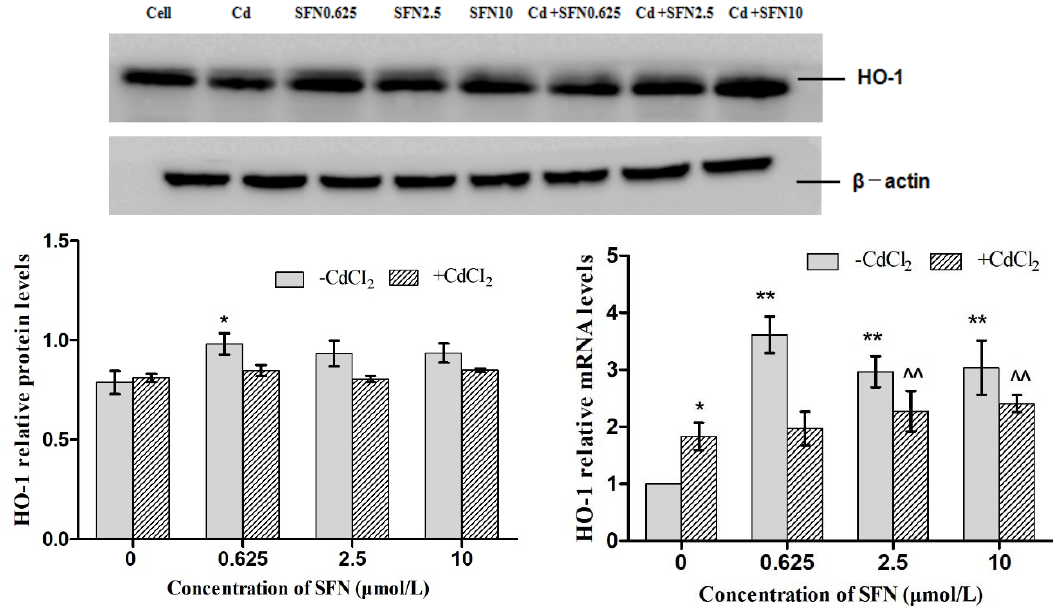
Figure 9. Effects of SFN on Cd induced the relative mRNA and protein expression of HO-1 of the TM4 cells. * p < 0.05 as compared to the control group, ** p < 0.01 as compared to the control group, ˆˆ p < 0.01 as compared to the Cd group.